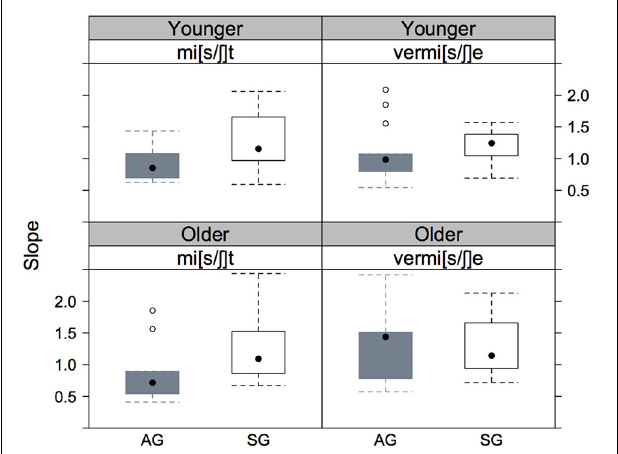
FIGURE 5 | The distribution of the listener-specific slopes on the three fixed factors. There is one point per listener in each distribution. The rectangle spans the inter-quartile range; the black dot in the center of the rectangle is the distribution’s median.